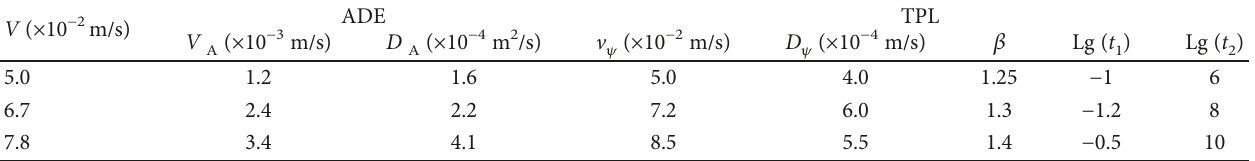
Table 4: The parameters of BTCs at three